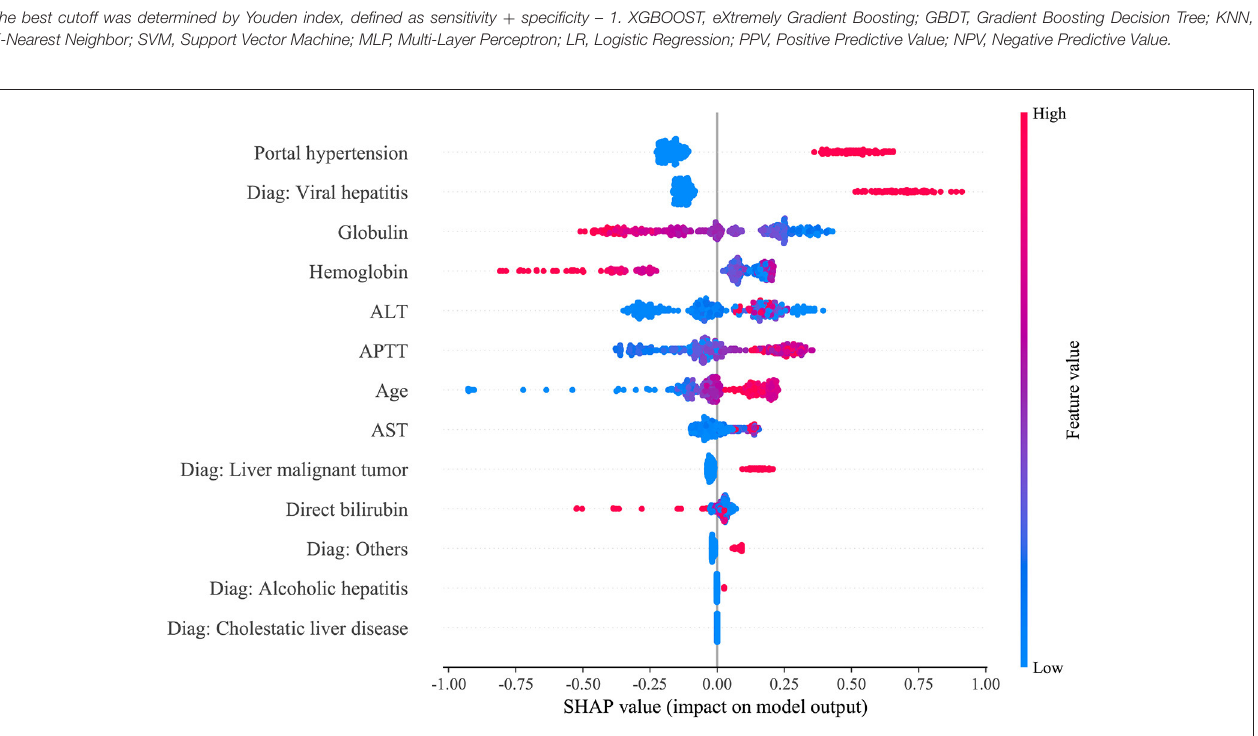
FIGURE 3 | SHAP analysis of the proposed model on the validation set. This figure described data from the validation set, with each point representing one patient. The color represents the value of the variable; red represents the larger value; blue represents the smaller value. The horizontal coordinates represent a positive or negative correlation with transfusion risk, with a positive value indicating a risk of transfusion and a negative value indicating no need for transfusion. The absolute value of the horizontal coordinate indicates the degree of influence; the greater the absolute value of the horizontal coordinate, the greater the degree of